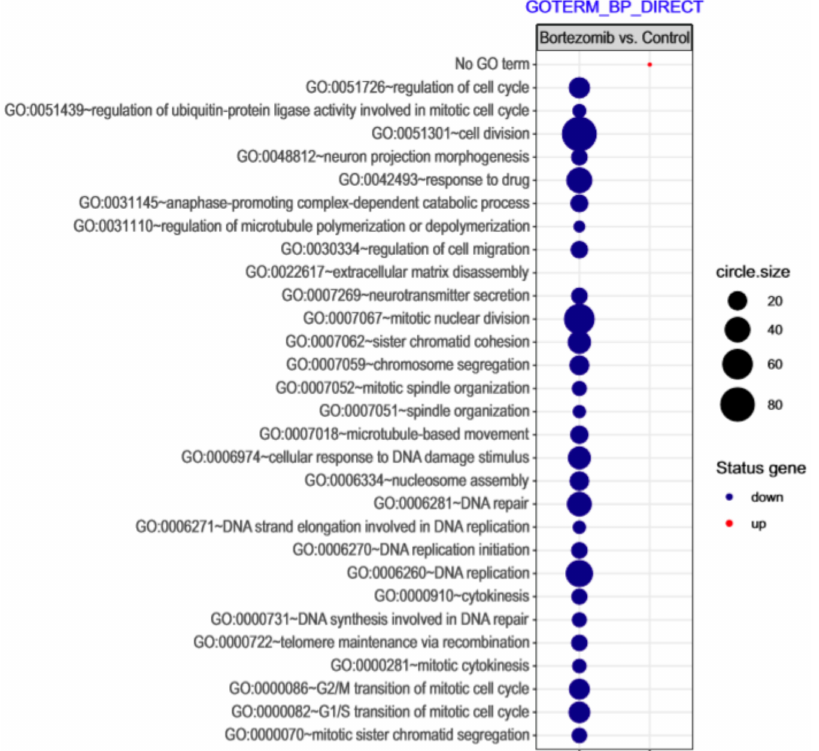
Figure 2. The bubble plot with changed biological processes assigned according to Gene Ontology (GO) classification in bortezomib-treated PC12-derived nerve cells compared to the control cells. Genes assigned to individual processes fulfilling the criteria: Adjusted p < 0.05, method = Benjamini, and minimum number of genes per group = 5, are presented. The bubble size indicates the number of genes represented in the corresponding